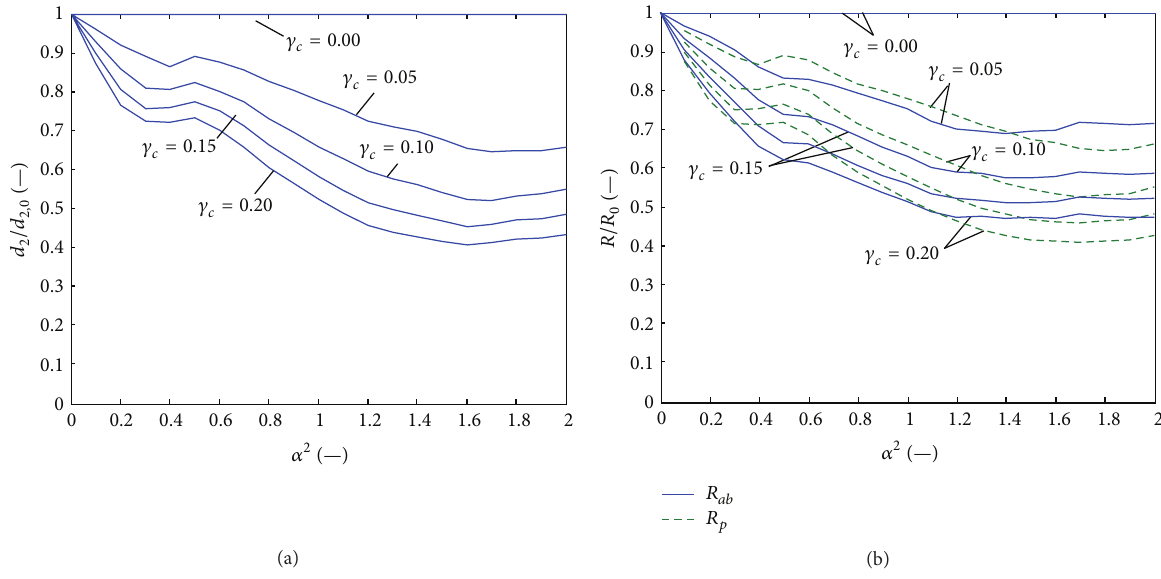
Figure 8: Variation with 𝛼 2 and for different values of 𝛾 𝑐 of normalized deck centre transverse displacement 𝑑 2 /𝑑 2,0 and of the normalized total pier and abutment reactions ( 𝑅 𝑝 /𝑅 𝑝,0 and 𝑅 𝑎𝑏 /𝑅 𝑎𝑏,0 ).